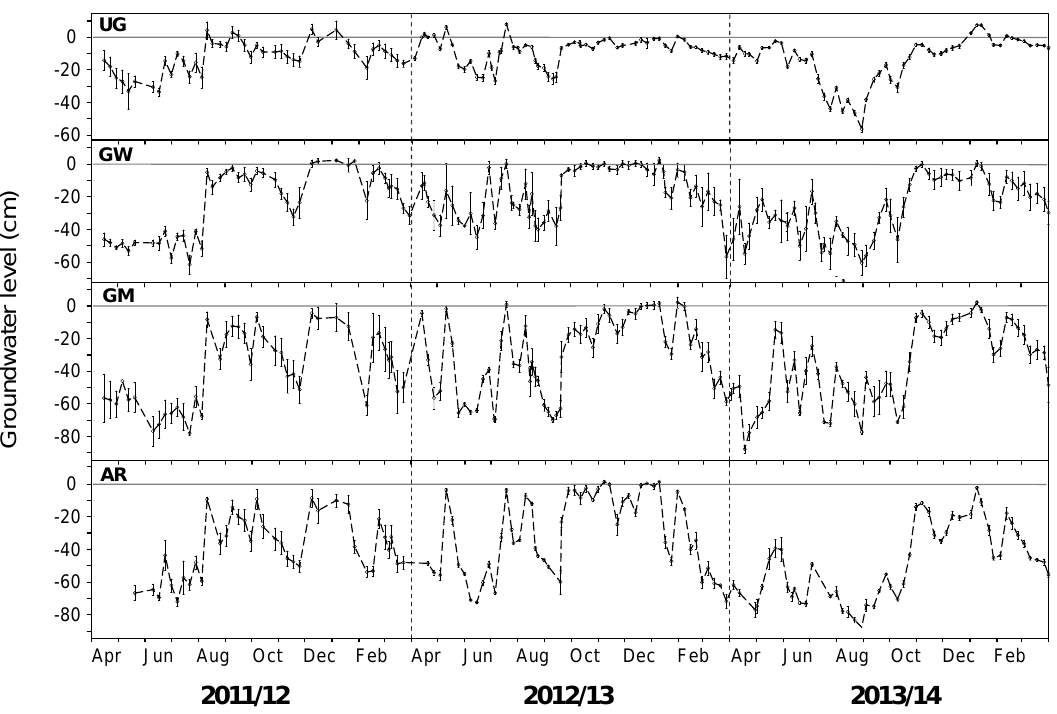
Figure 2. Development of GWLs at the four study sites during the study period (April 2011–March 2014). Displayed are mean values ± standard errors of the manually recorded GWLs during gas flux measurements ( n = 4).